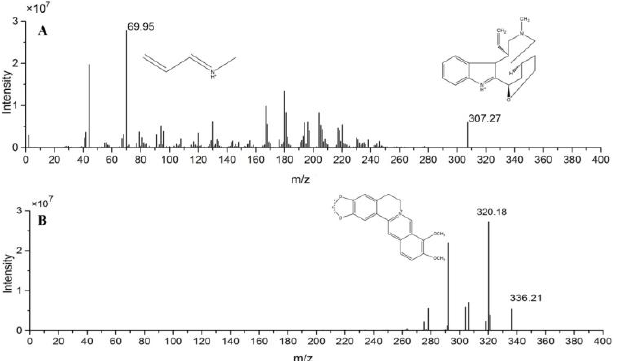
Figure 1. Chemical structures and full scan product ion of precursor ions of koumine (KM) ( A ) and IS ( B